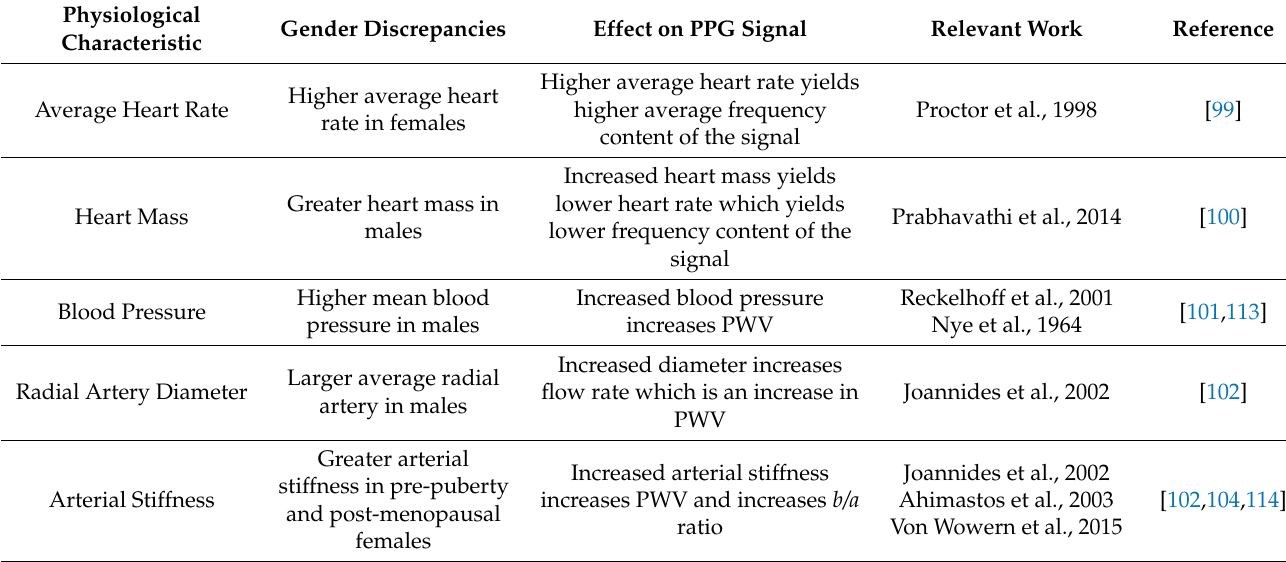
Table 4. Gender-induced changes on